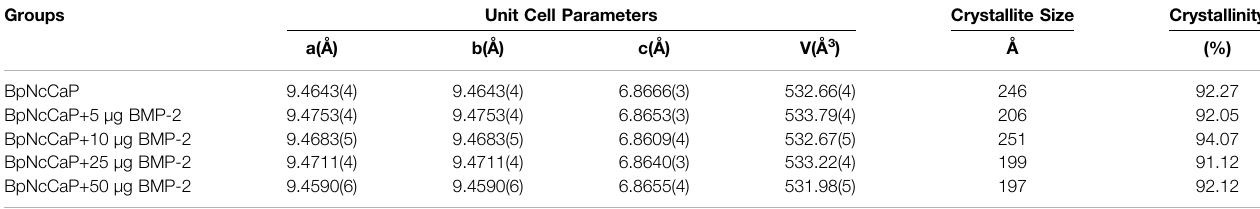
TABLE 2 | Unit cell parameters, crystallite sizes and crystallinities of BpNcCaPs without or with different amounts (5/10/25/50 μ g) of BMP-2.